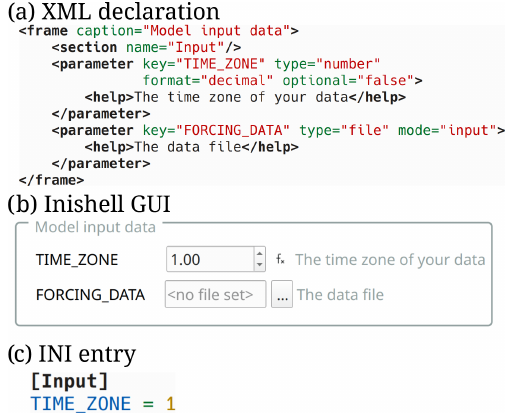
Figure 7. Constructs to visually group elements together: sections and frames (panels a , b , and c are similar to those of Fig. 6).